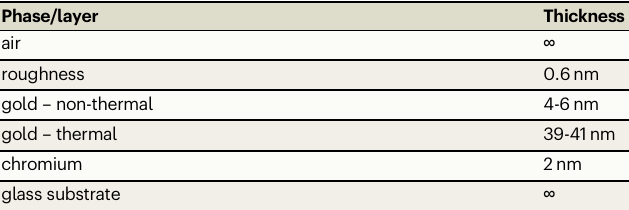
Table 1 | Different phases/layers of the investigated plasmonic system and their